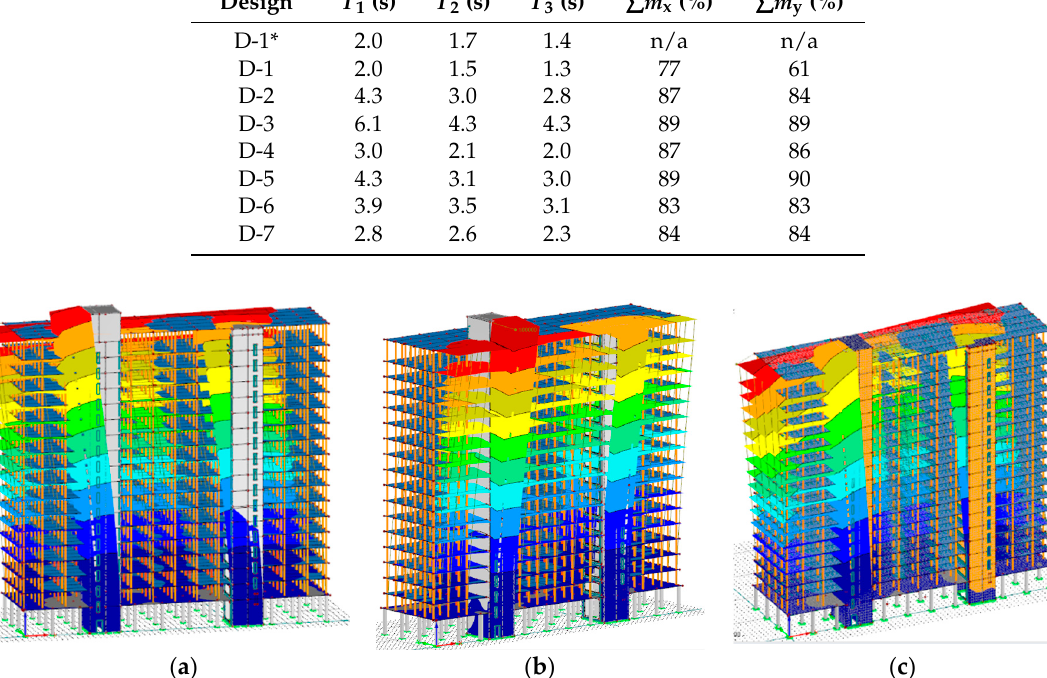
Figure 6. Mode shapes of TWB ( a ) 1st: translation in X -direction; ( b ) 2nd: translation in X -direction; ( c ) 3rd torsion.